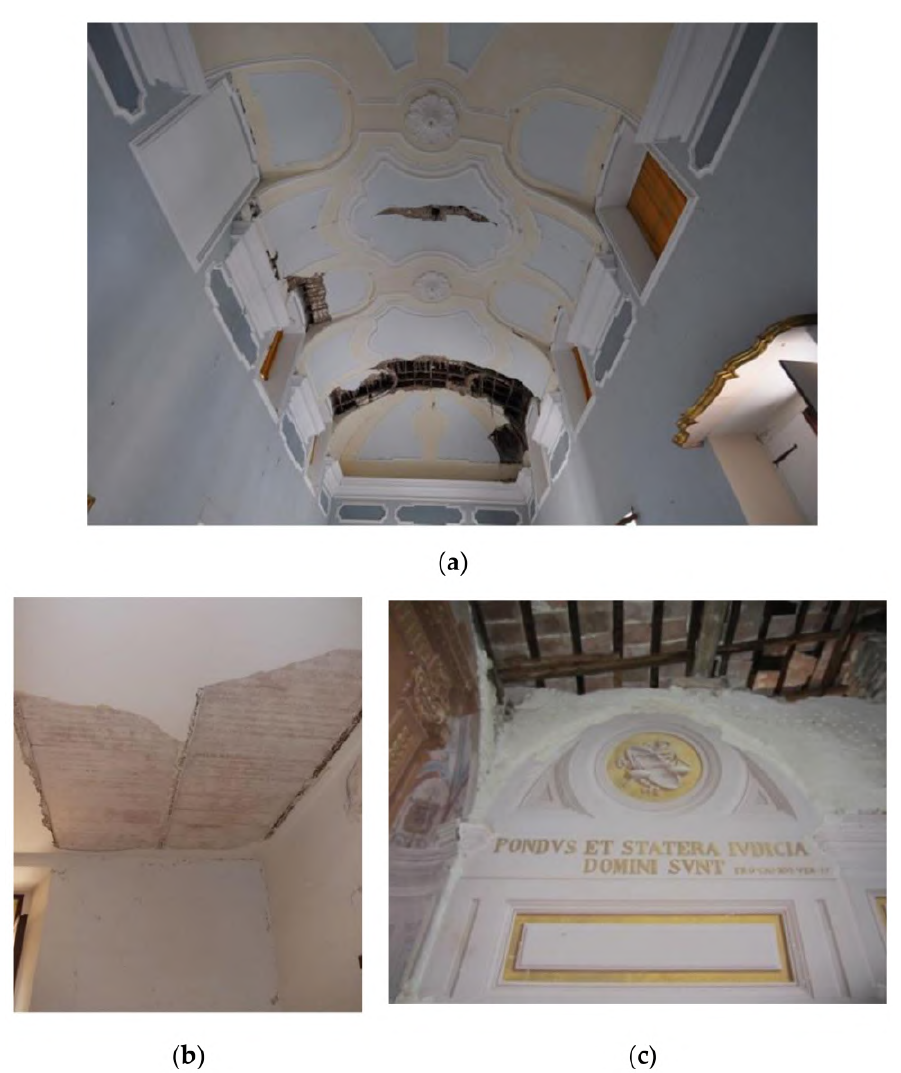
Figure 9. Views of some floor typologies detected in L’Aquila: ( a ) HS3; ( b ) HS4; ( c ) HS1. HS, Horizontal